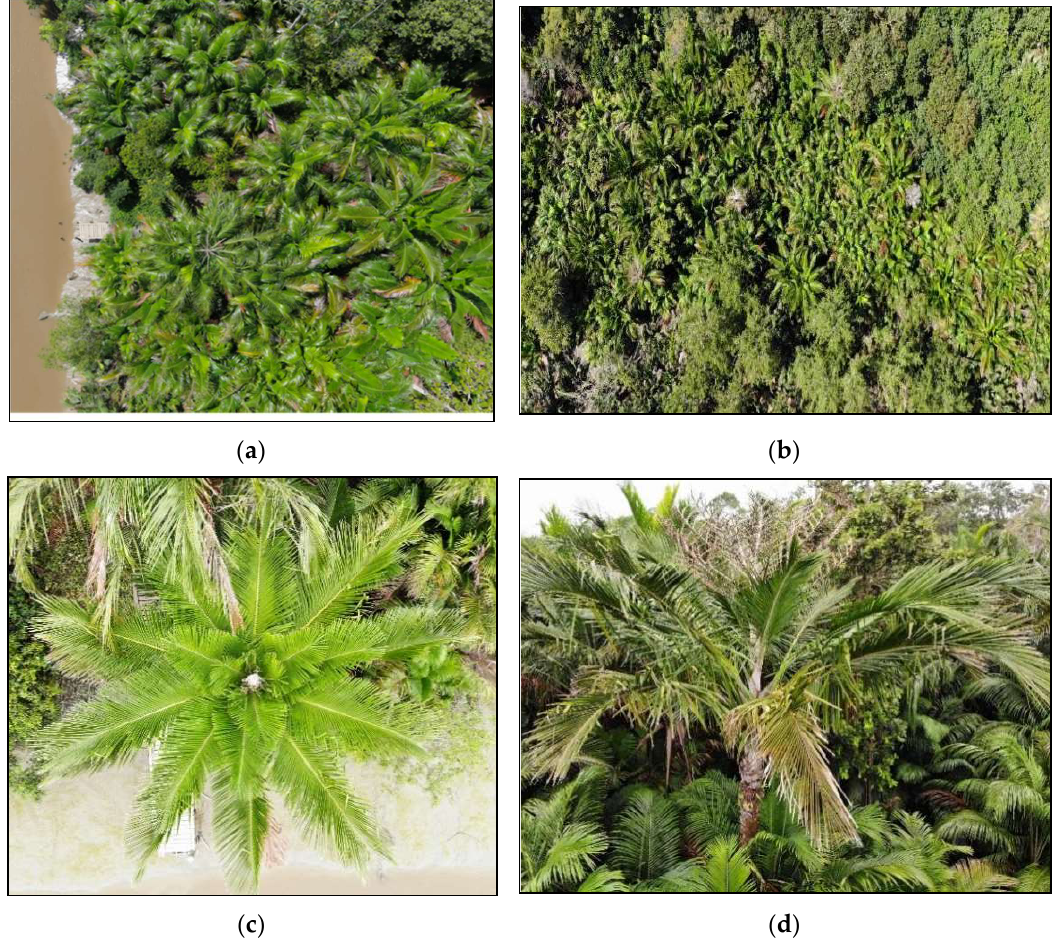
Figure 3. Sago palm captured imagery using UAV RGB and ground photography observation. ( a ) and ( b ) Sago palm areas in the fieldwork, and other vegetation (blue rectangle); ( c ) Sago flowers defined by white flowers at top center, between leaves. It is visualised by yellow rectangles ( d ) Palm tree dominant features: trunk and leaves, which represented by orange, black rectangles, respec- tively.